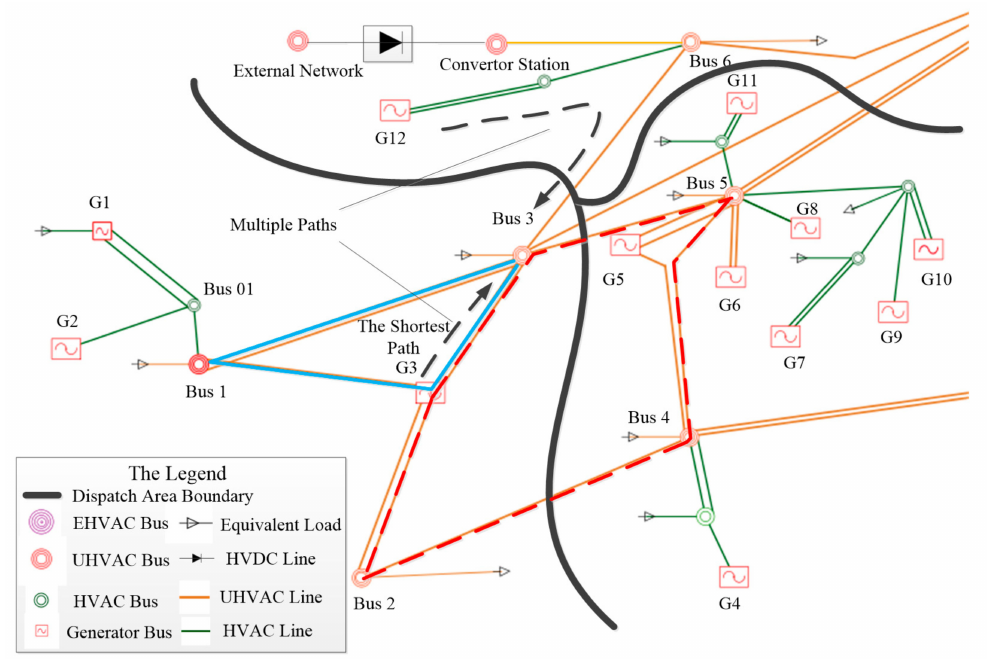
Figure 3. Dispatch areas of the partial power